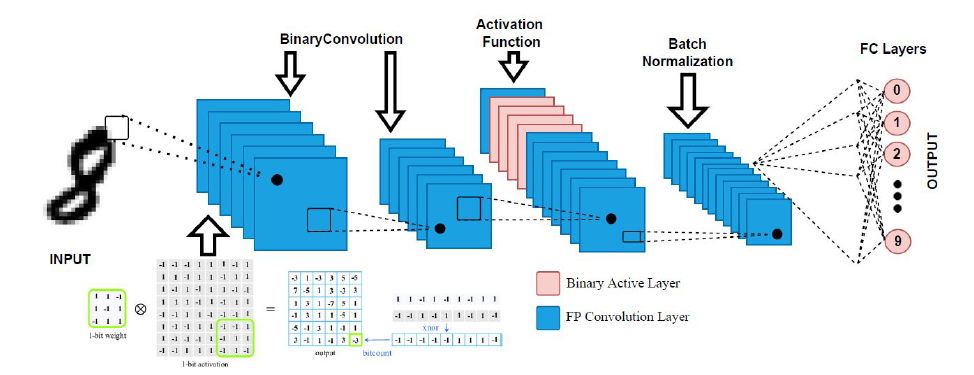
Figure 2. Architecture of a